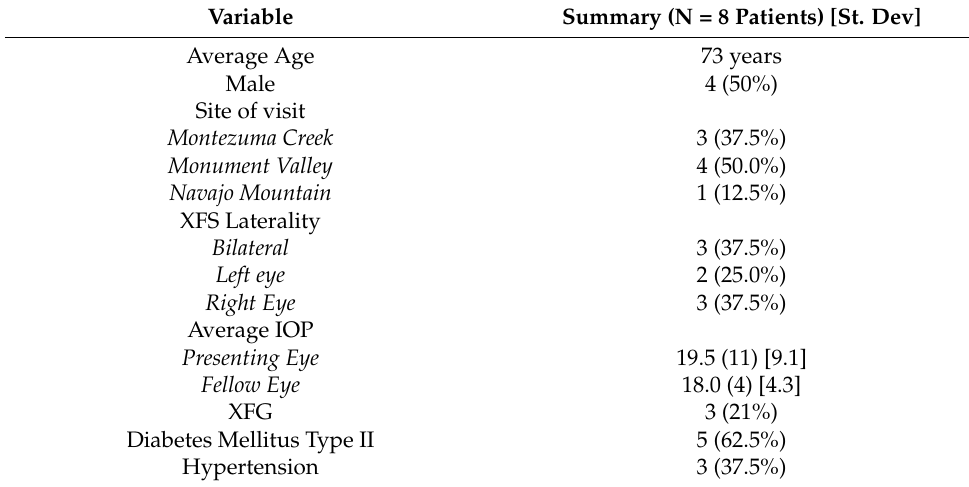
Table 2. Descriptive Summary of Patients with